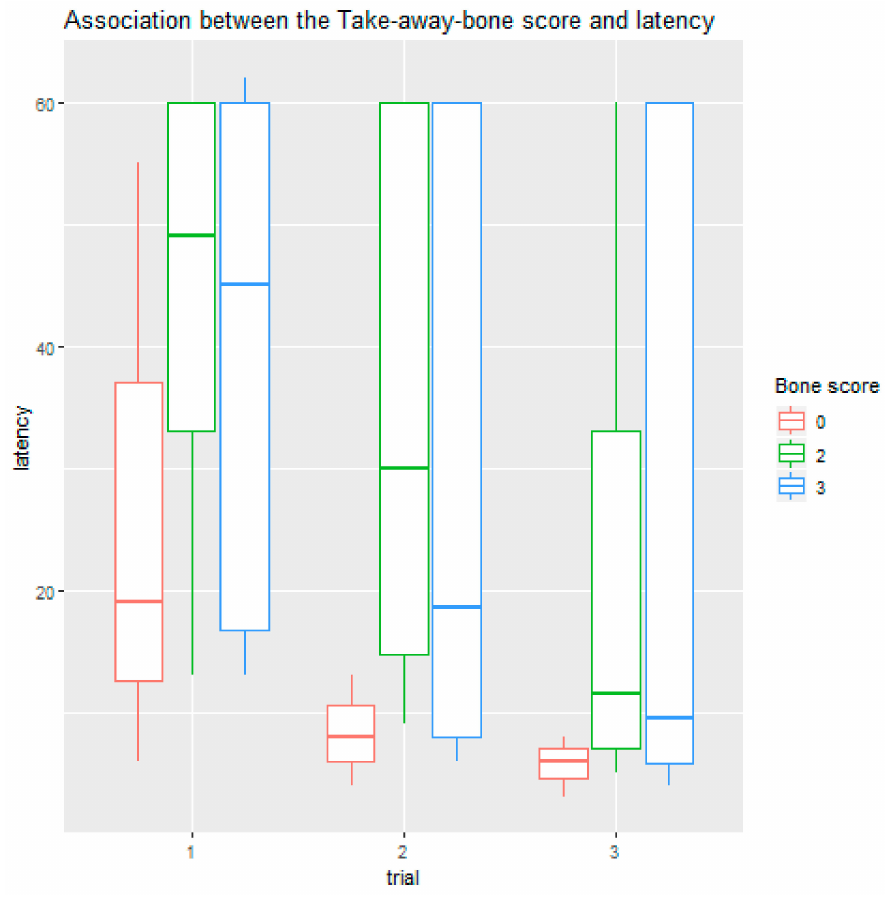
Figure 4. Dogs that gave the bone up the easiest in the Take-away-bone test solved the detour faster after the experimenter demonstrated the